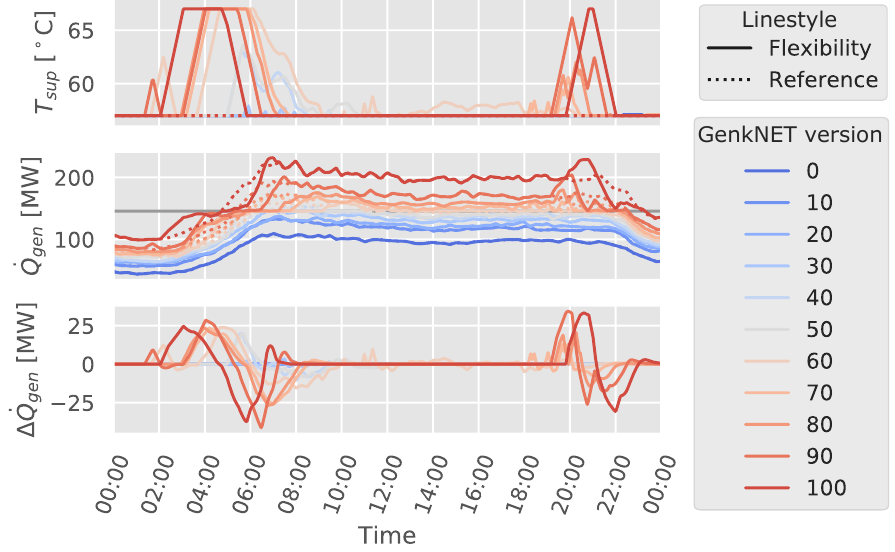
Figure 9. For the Winter_Large ∆ p e day, the results of the base-peak plant optimisation for the 11 selected GenkNET versions with a base load ratio of 95% are shown. From top to bottom, the supply temperature at the plant, the heat injection and the heat injection response are shown. In the middle graph, the maximum heat output of the base unit is indicated by the grey horizontal line.